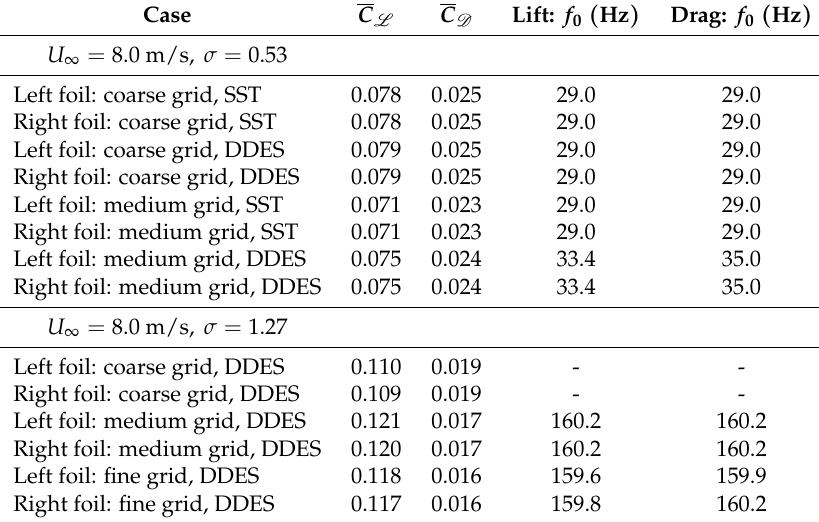
Table 2. Comparison of the mean lift and drag coefficients ( C L and C D , respectively), and their dominant frequencies ( f 0